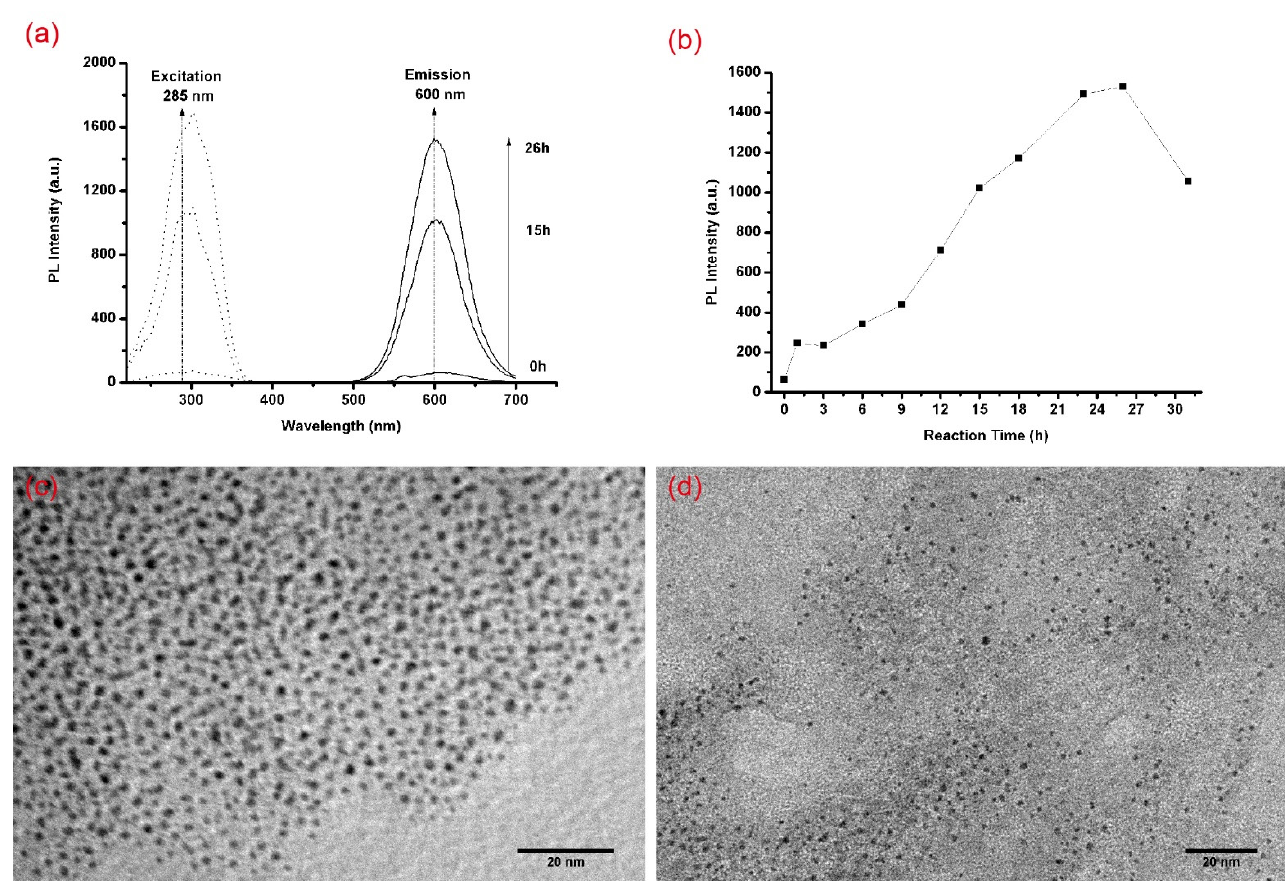
Figure 1. ( a ) The variations in the excitation and emission spectra; ( b ) the variations in PL intensity in the synthesis process of AuNC@MUA; ( c ) a TEM image of as-synthesized AuNP@MUA; ( d ) a TEM image of as-synthesized AuNC@MUA. The small sharp peaks at 300 nm in the excitation spectra were from the scattering of the light source.